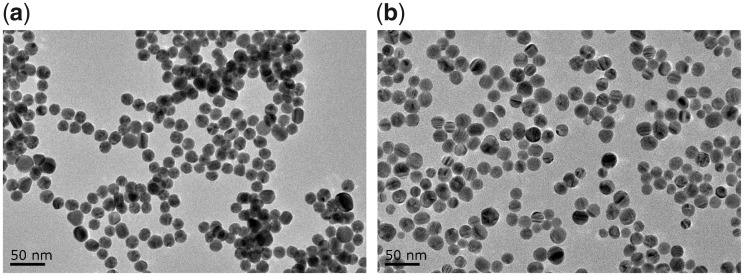
TEM Images of (a) GNPs and (b) SNPs